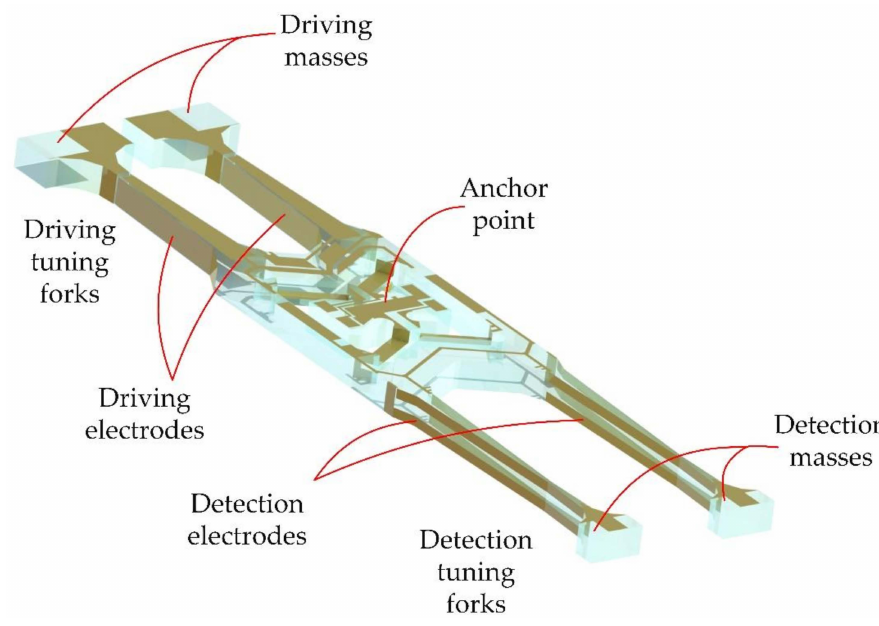
Figure 3. The structure of micro quartz tuning forks gyroscope.